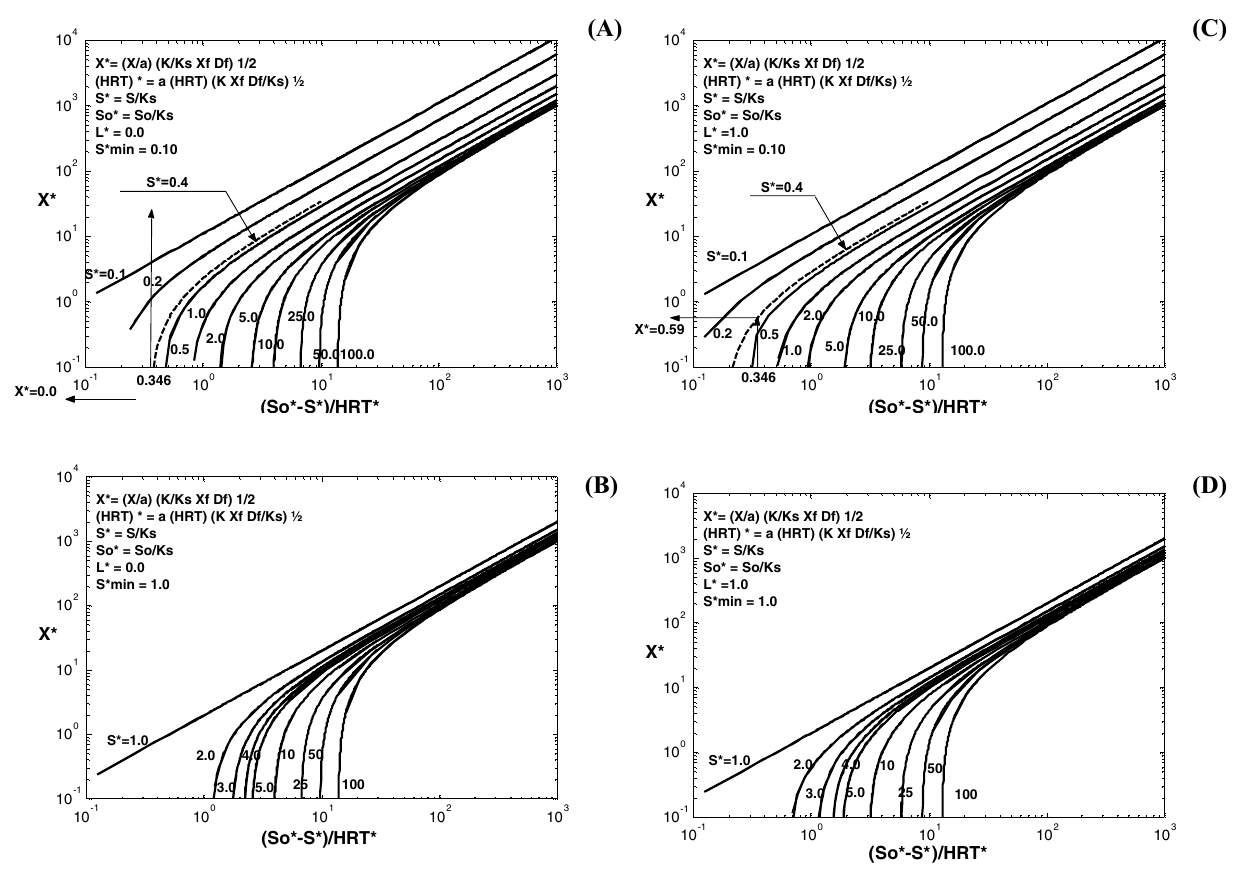
Fig. 2 X * as a function of S * and ( S ∗ o − S )/HRT at a L * = 0.0, S ∗ min = 0.10, b L * = 0.0, S ∗ min = 1.0, c L * = 1.0, S ∗ min = 0.10 and d L * = 1.0, S ∗ min =